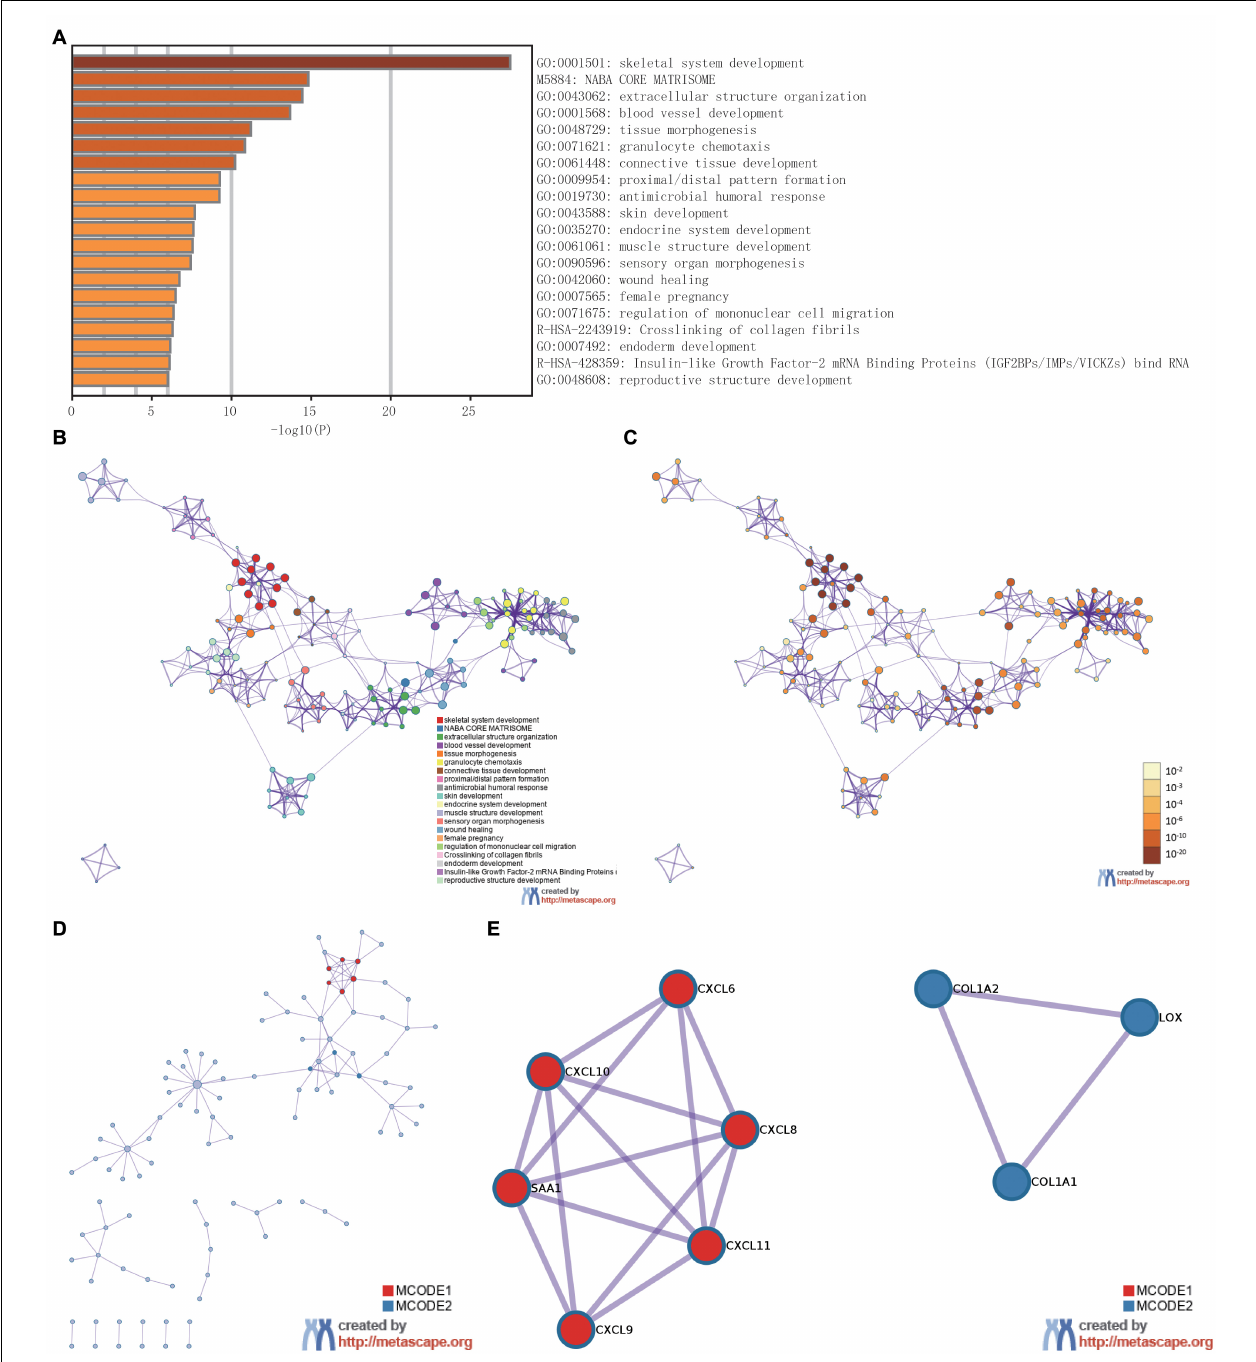
FIGURE 8 | The enrichment analysis and visualized protein-protein interaction (PPI) enrichment analysis of DEGs (Metascape). (A) A heatmap of Gene Ontology analysis colored by P -values. (B,C) An interactive network of the top 20 enrichment terms. (D,E) PPI network and densely connected network components identified by the Molecular Complex Detection (MCODE)